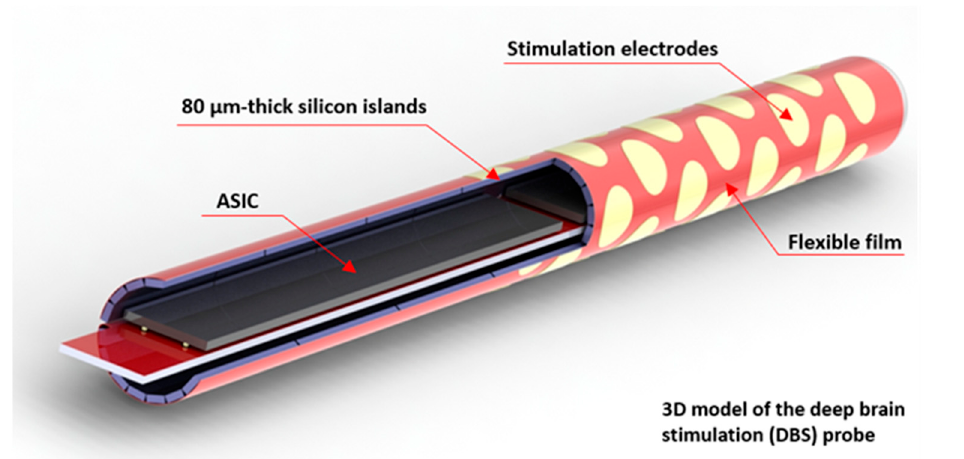
Figure 4. 3D model of the 40-electrode DBS probe (ø 1.4 mm diameter) with integrated capacitors and ASICs inside the probe’s tip.